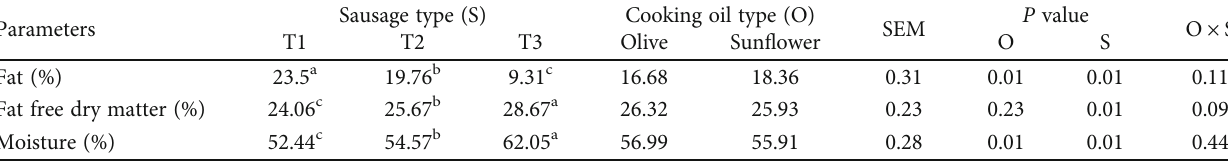
Table 2: E ff ect of cooking oil on the proximate composition of the beef sausage forti fi ed with edible meat wastes.